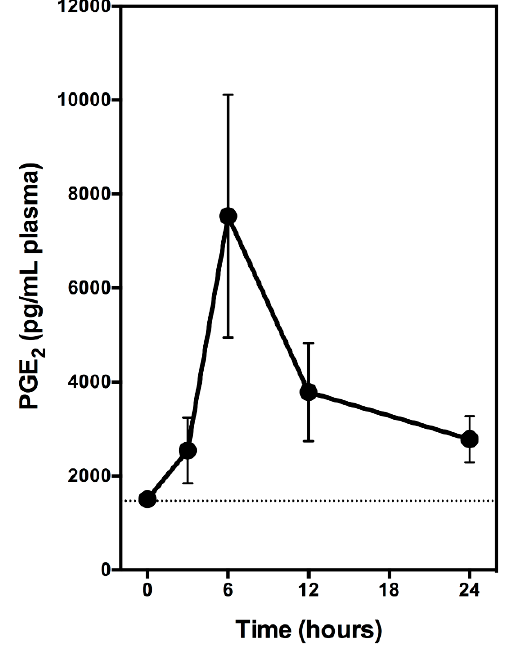
Figure 4. The time course for the stimulatory effect of ethyl gallate on the plasma levels of PGE 2